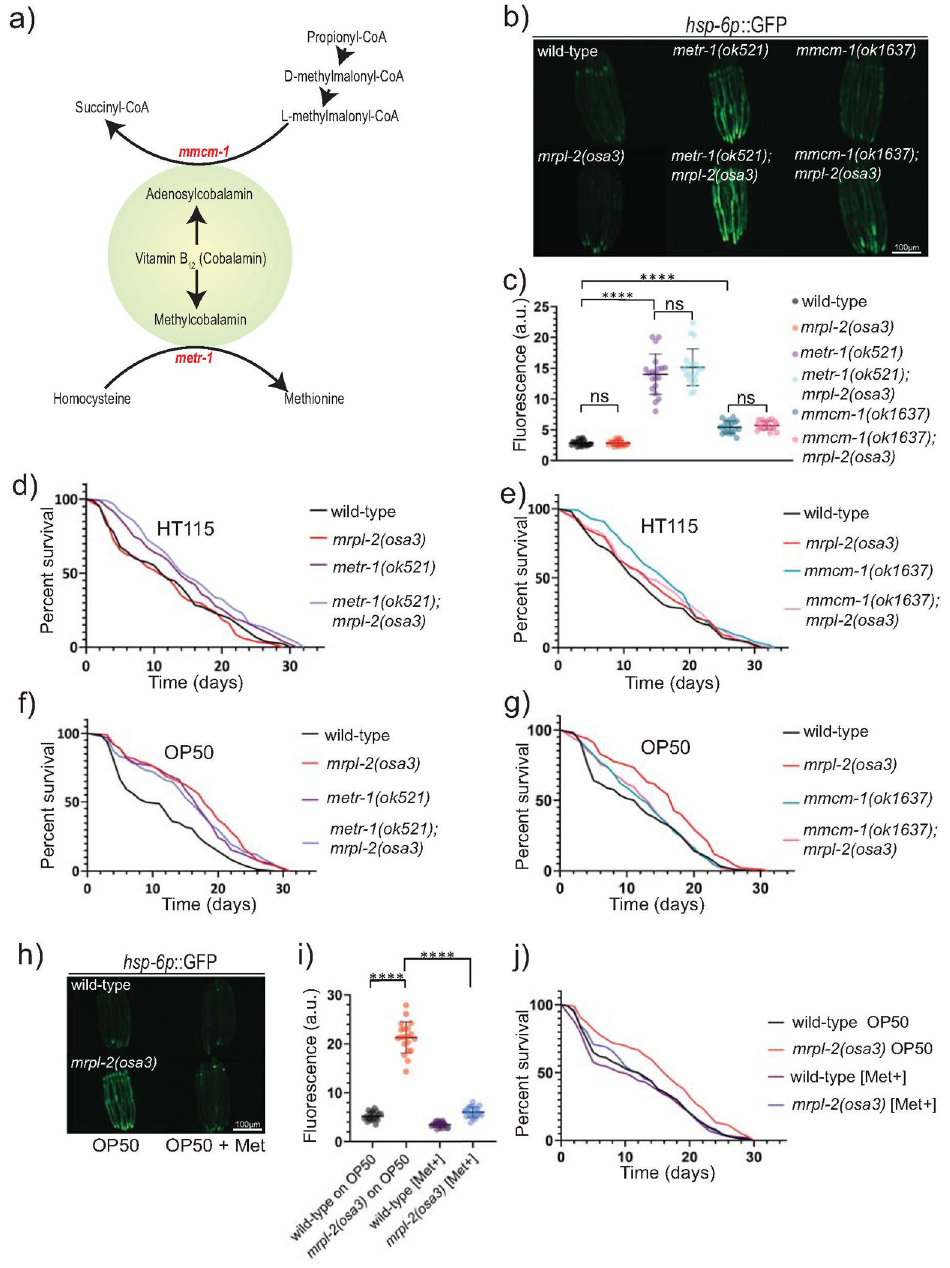
Fig 6. Methionine supplementation suppresses UPR mt activation in mrpl-2(osa3) animals fed a vitamin B12 deficient diet. (A) Schematic illustration of vitamin B12-dependent metabolic pathways. (B, C) Photomicrographs and quantification of hsp-6p ::GFP expression of wild-type, mrpl-2(osa3) , metr-1(ok521) , mmcm-1(ok1637) , metr-1(ok521); mrpl-2(osa3) , and mmcm-1(ok1637); mrpl-2(osa3) fed an E . coli HT115 diet. Quantification of fluorescence intensities expressed as arbitrary units (A.U.); (mean ± SD; n � 20); ns denotes not significant, ���� denotes p � 0.0001 (Student’s t test). (D) Lifespans of wild-type, mrpl-2(osa3) , metr-1(ok521) , metr-1(ok521); mrpl-2(osa3) fed an E . coli HT115 diet. (E) Lifespans of wild-type, mrpl-2(osa3) , mmcm-1(ok1637) , mmcm-1(ok1637); mrpl-2(osa3) fed an E . coli HT115 diet. (F) Lifespans of wild-type, mrpl-2(osa3) , metr-1(ok521) , metr-1(ok521); mrpl-2(osa3) fed an E . coli OP50 diet. (G) Lifespans of wild-type, mrpl-2(osa3) , mmcm-1(ok1637) , mmcm-1(ok1637); mrpl-2(osa3) fed an E . coli OP50 diet. (H, I) Photomicrographs and quantification of hsp-6p ::GFP expression of wild-type and mrpl-2(osa3) fed an E . coli OP50 diet in the presence or absence of 10 mM methionine. Quantification of fluorescence intensities expressed as arbitrary units (A.U.); (mean ± SD; n 20); denotes p 0.0001 (Student’s t test). (J) Lifespans of wild-type and mrpl-2(osa3) fed an E . coli OP50 diet in the presence or absence of 10 mM methionine.